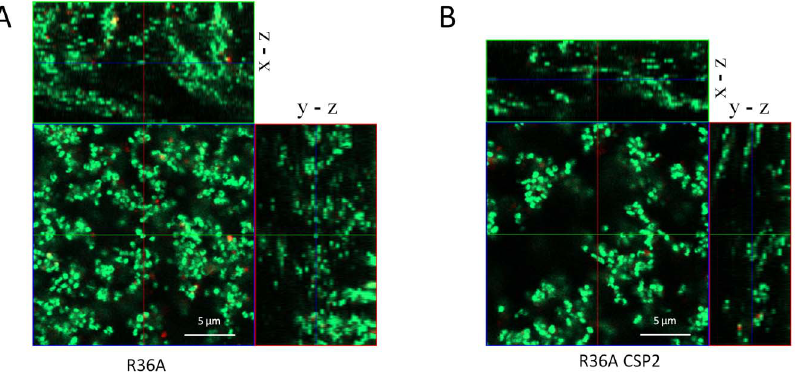
Figure 3. Confocal laser scanning microscopy (CLSM) images of R36A and R36A-CSP2 biofilms. R36A and R36A-CSP2 were grown for 24 h at 37 u C and examined by CLSM. A representative image is shown. Live cells are stained in green and dead cells in red. Images show that R36A forms biofilms that are around 30% thicker and more densely packed than R36A-CSP2 biofilms.